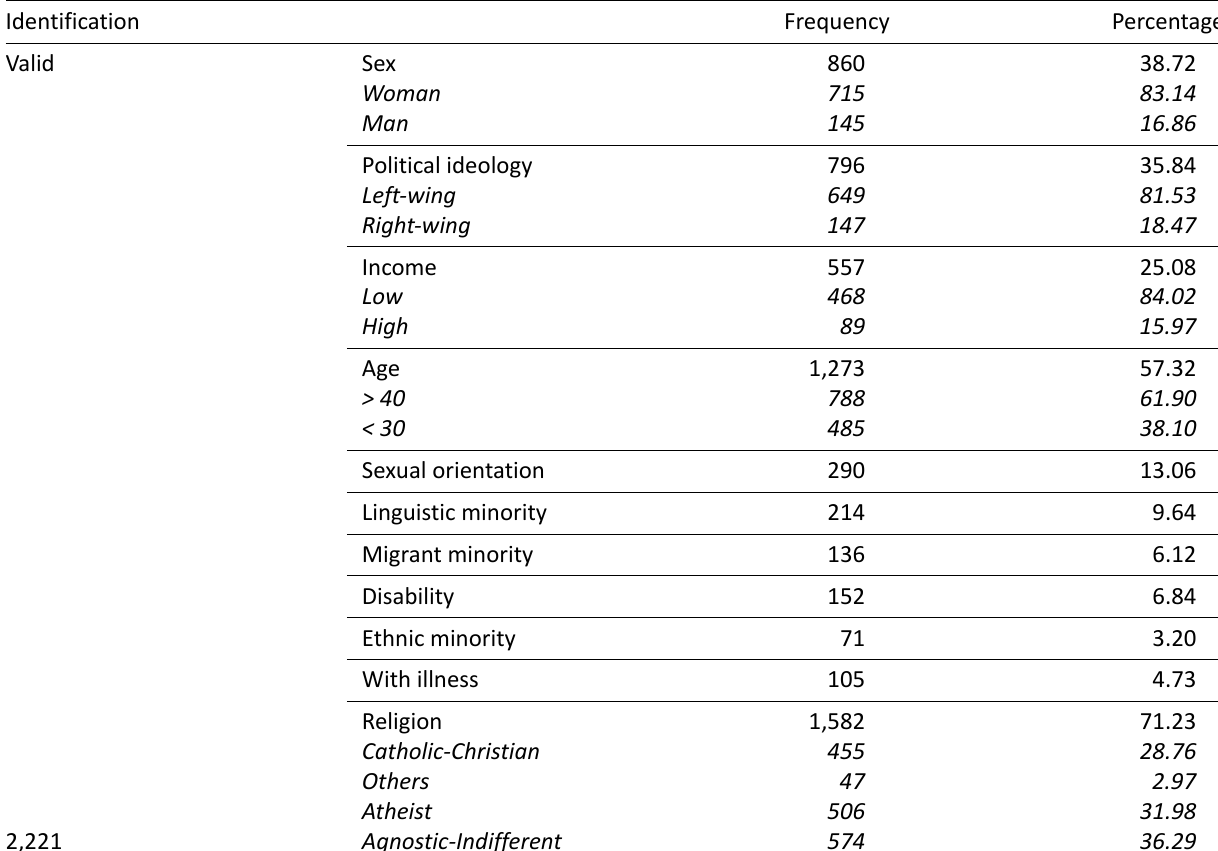
Table 2. Identification with protected groups.